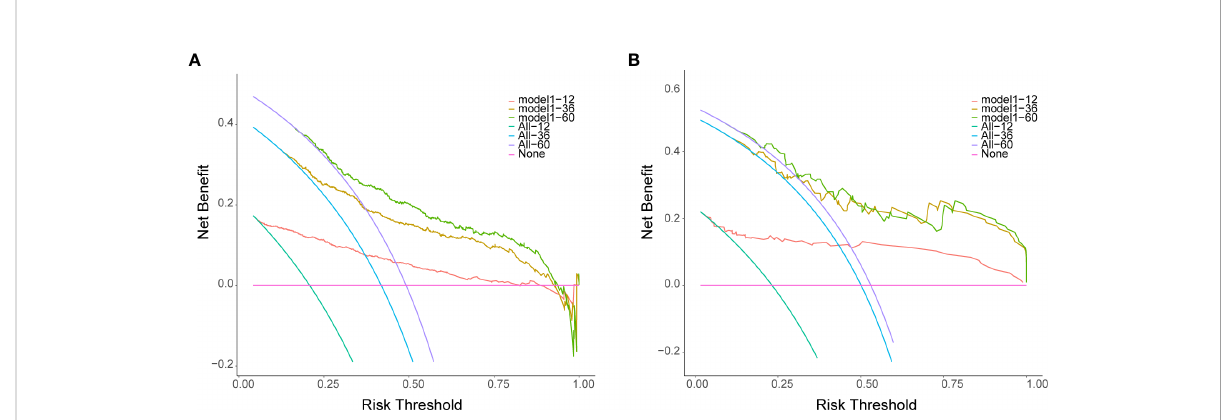
FIGURE 9 Decision curves for the DL survival Cox model for 1-, 3-, 5-years in the training set (A) and validation set (B) . The X-axis indicates thresholds probability for lung metastasis risk, and the Y-axis indicates net bene fi ts depending on different thresholds probability. The pink horizontal line parallel to the X-axis represents no clinical action taken by any patient ( “ treat none ” ) and their net clinical bene fi t is 0. The smooth arc line represents that all patients took clinical action ( “ treat all ” ), and their net clinical bene fi t is a backslash with a negative slope. The curve of “ treat by DL survival Cox model ” is then compared to “ treat all ” and to “ treat none ”